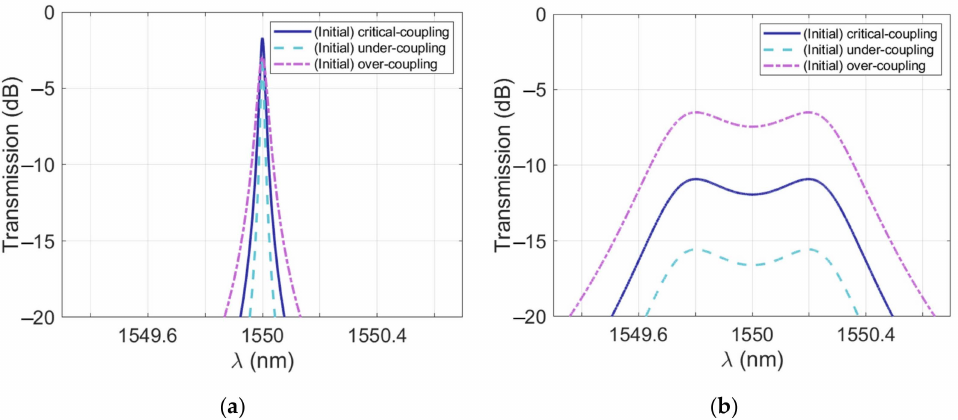
Figure 5. Bandwidth-tunable range of the system under different initial coupling states. ( a , b ) The transmission spectra of the drop port at the minimum and maximum bandwidth of the system, where the system bandwidth of different colored lines are 2.35 GHz, 1.53 GHz, 4.65 GHz and 85.02 GHz, 84.64 GHz, 86.17 GHz,